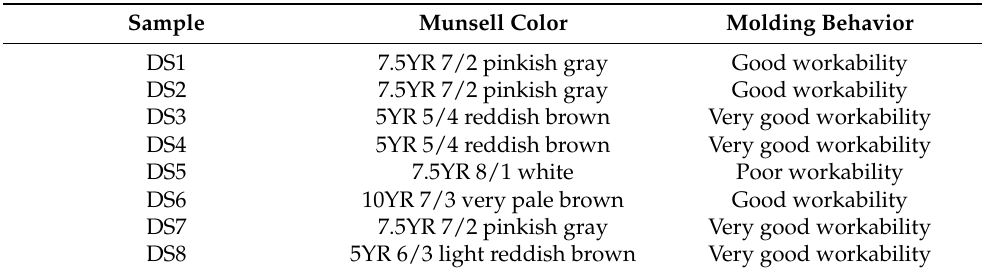
Table 1. The color of the unfired (leather dried) clays and their behavior during molding. Sample Munsell Color Molding